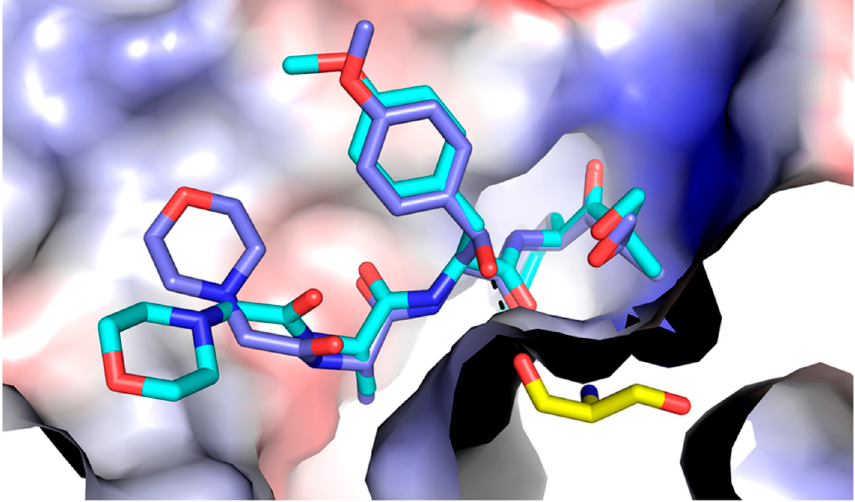
Figure 3. Modeling of KZR-616 (purple) and ONX 0914 (blue) in the LMP7/ β 6 binding site. Taken from Reference [20].